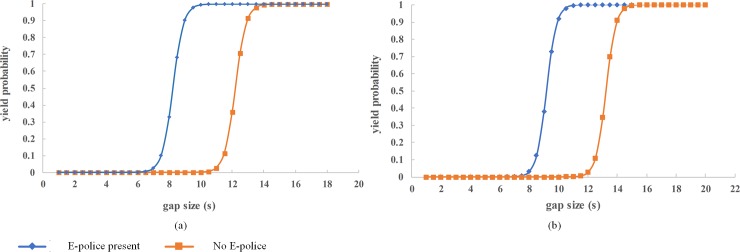
Influence of gap size on vehicle yielding.